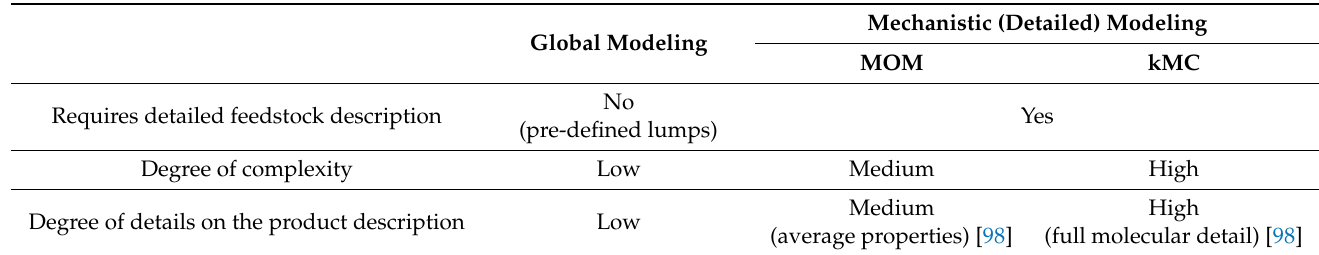
Table 2. Overal comparison of different kinetic modeling approaches with a focus on multi-scale modeling of